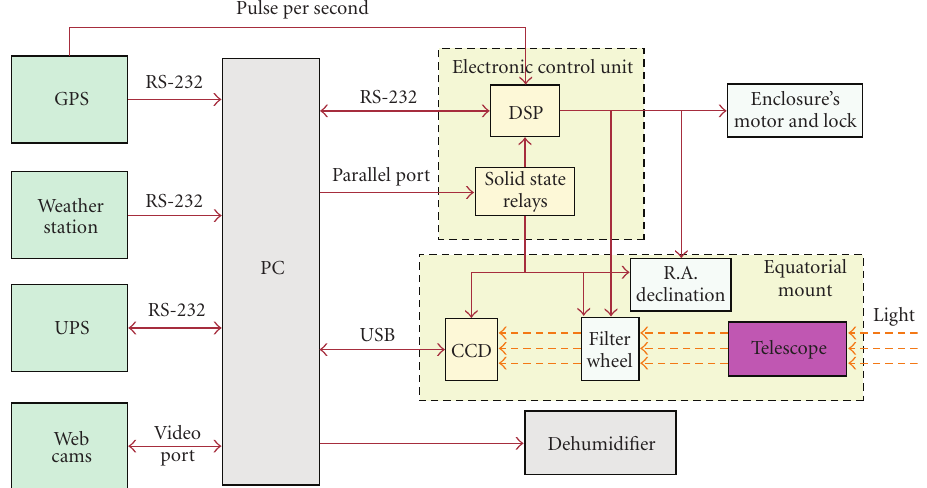
Figure 1: Block diagram of the telescope system.